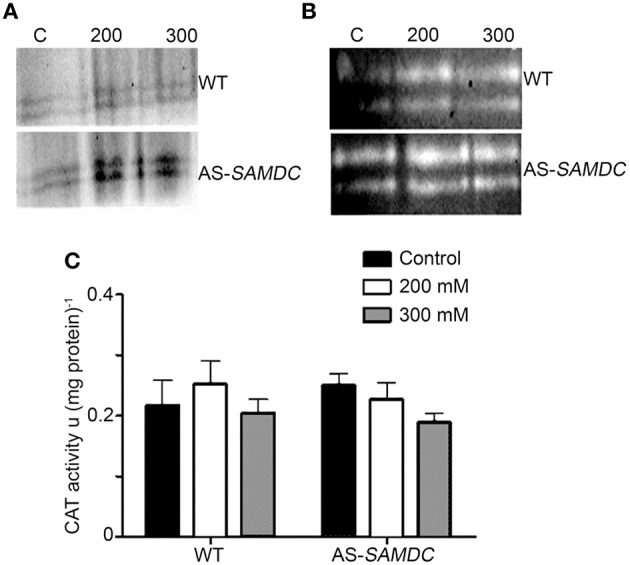
Activities of NADPH-oxidase, SOD and CAT in WT and AS-SAMDC plants under control and 24 h post-treatment with 200 or 300 mM NaCl. (A) In-gel activity assay of NADPH-oxidase. Images are from a single representative experiment replicated three times. C, control. (B) In-gel activity assay of cytoplasmic (CuZn-SOD; upper band) or mitochondrial SOD (Mn-SOD; lower band). Images are from a single representative experiment replicated three times. C, control. (C) Specific activity of CAT. Data are means ± SD of three biological replicates.